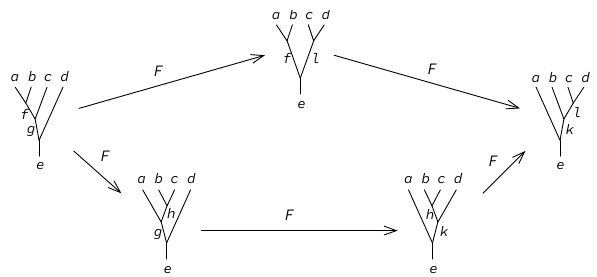
Figure 4: In the original theory, sliding an anyon line through the defect trijunction ( g , h ) . In the new theory, the anyon line x must also pass through gave a phase (cid:17) x the Abelian anyon line associated with t ( g , h ) , which picks up the mutual braiding phase M between x and t ( g , h ) , as illustrated. x t ( g , h )